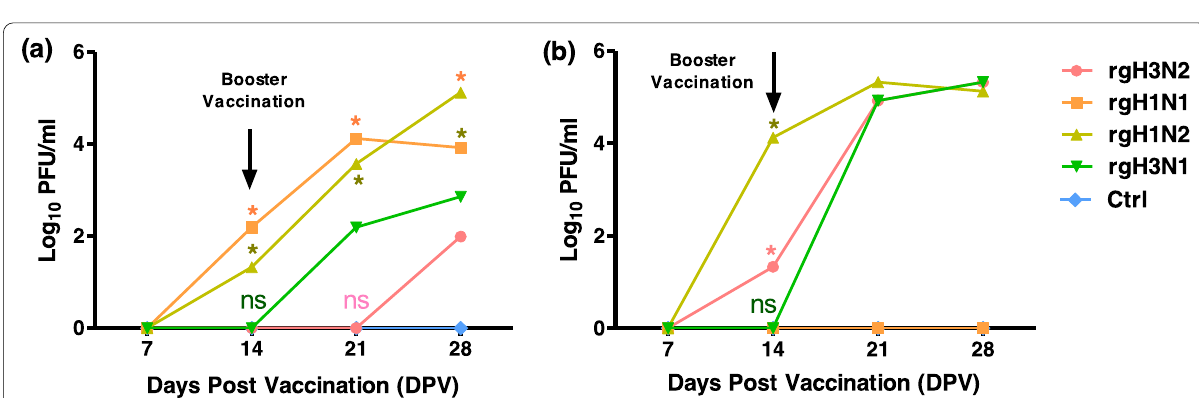
Fig. 6 Immunogenicity of inactivated candidate vaccine strains as measured by plaque reduction neutralization assay (PRNT) for the collected sera from vaccinated and control mice groups ( n 16 per group) at different time points post-vaccination. The sera plaque neutralization assay was = done against influenza A/H1N1 ( a ) and A/H3N2 ( b ). Statistical analysis was performed using one-way ANOVA followed by Tukey’s post hoc test. The significant differences are indicated (* P < 0.05 and non-significant =